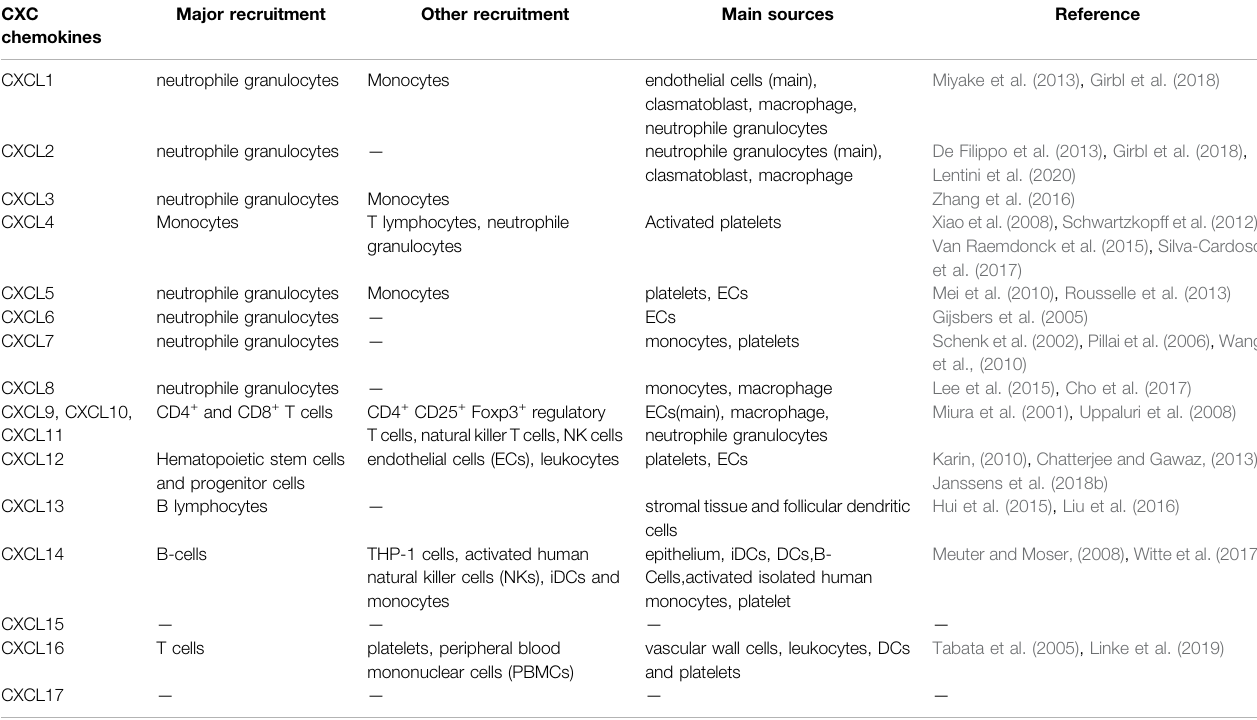
TABLE 1 | Recruitment cells of CXC chemokines and their main